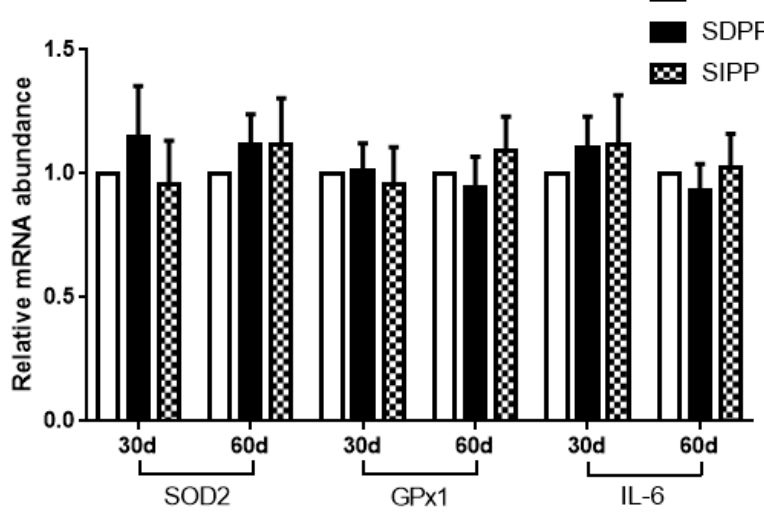
Figure 4. E ff ect of photoperiod change on relative gene expression of SOD2 , GPx1 and IL-6 ; CG: control Figure 4. Effect of photoperiod change on relative gene expression of SOD2, GPx1 and IL-6 ; CG: